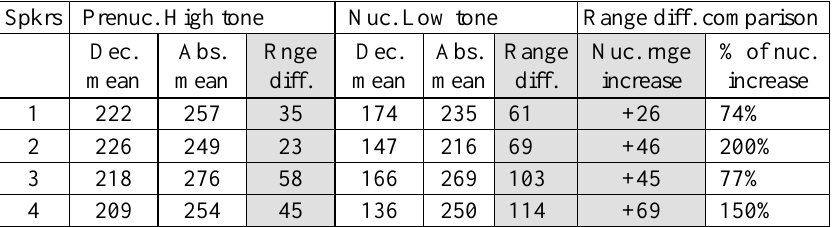
Table 4. Comparisons of tonal range differences of prenuclear High tones and nuclear Low tones between declaratives and absolute interrogatives and range of